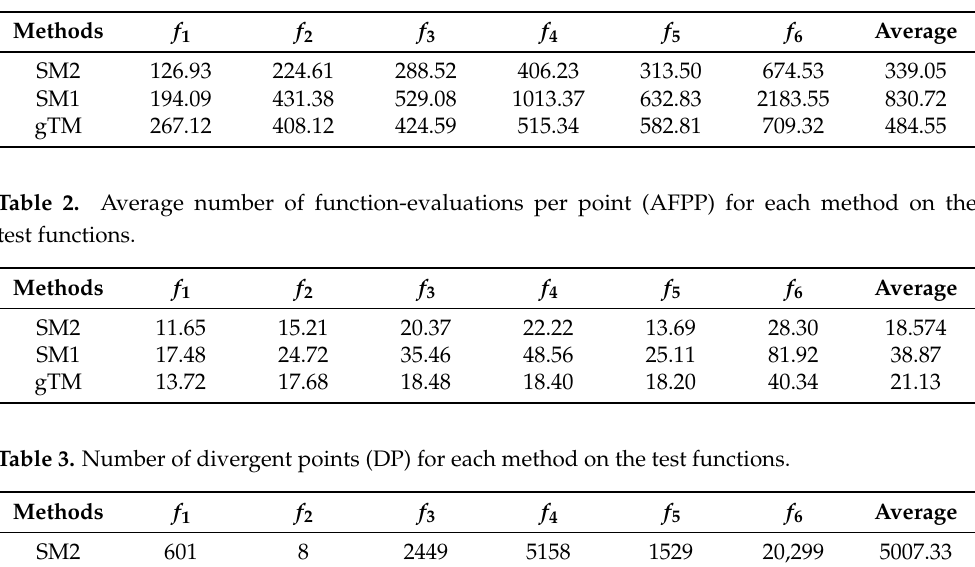
Table 1. CPU run-time (sec) for each method on the test functions.